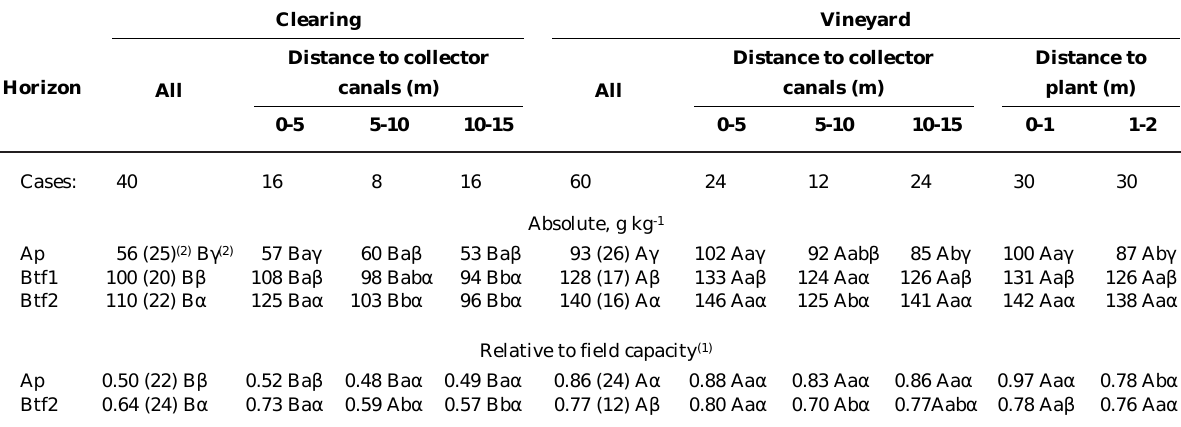
Table 3. Field soil water content (1) , according to sub-area as well as distance to collector canals and plants